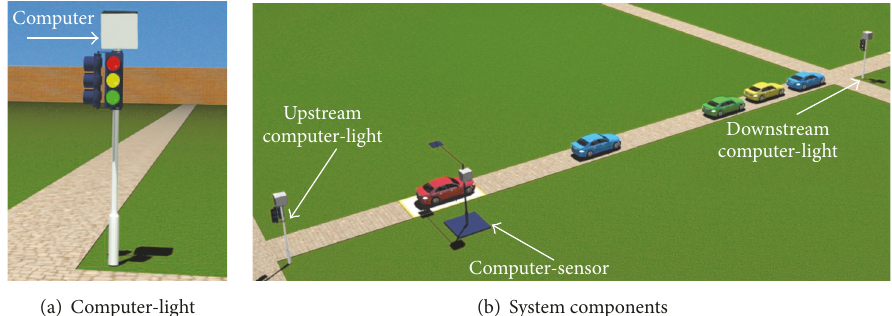
Figure 6: The computer-sensor sends information of the positions of the virtual vehicles predicted to the downstream computer-light . The computer-sensor also sends a message to the upstream computer-light to report if a vehicle is stationary in the sensing area. With information from local computer-sensors , each computer-light applies the self-organizing method.